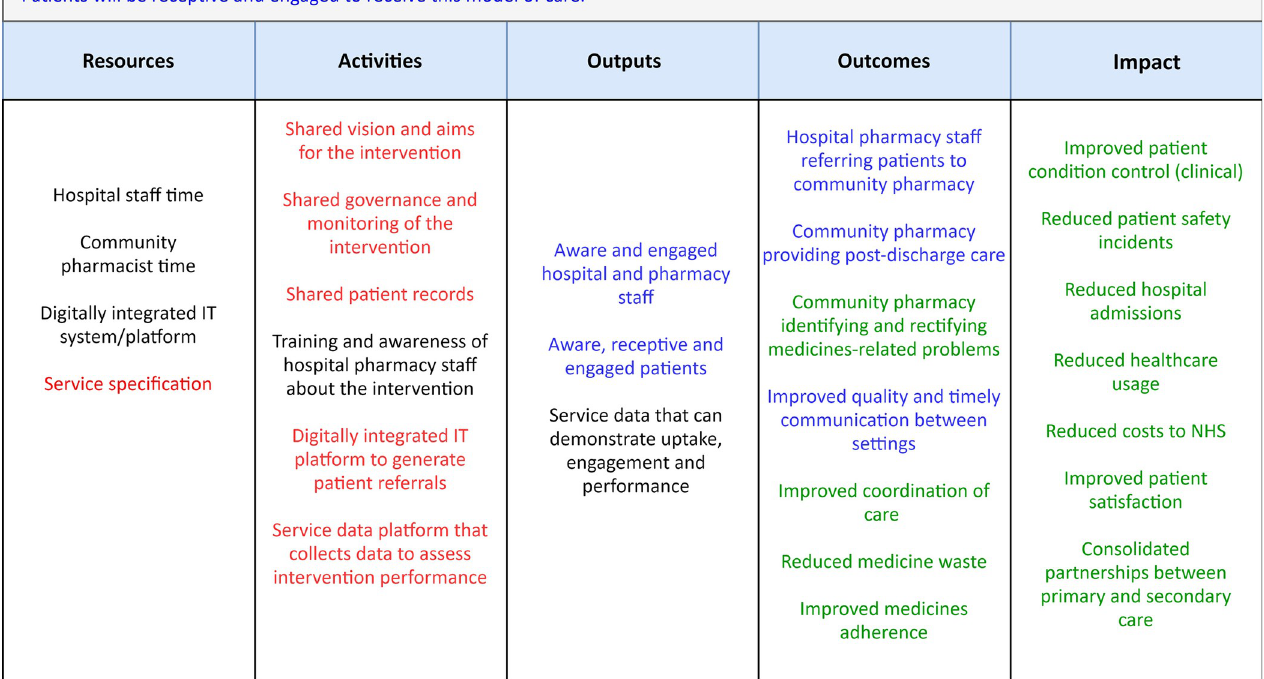
Fig 4. Refined logic model for the ToC intervention where assumptions have been confirmed (black), partially verified (blue), negated (red) or not captured in this study